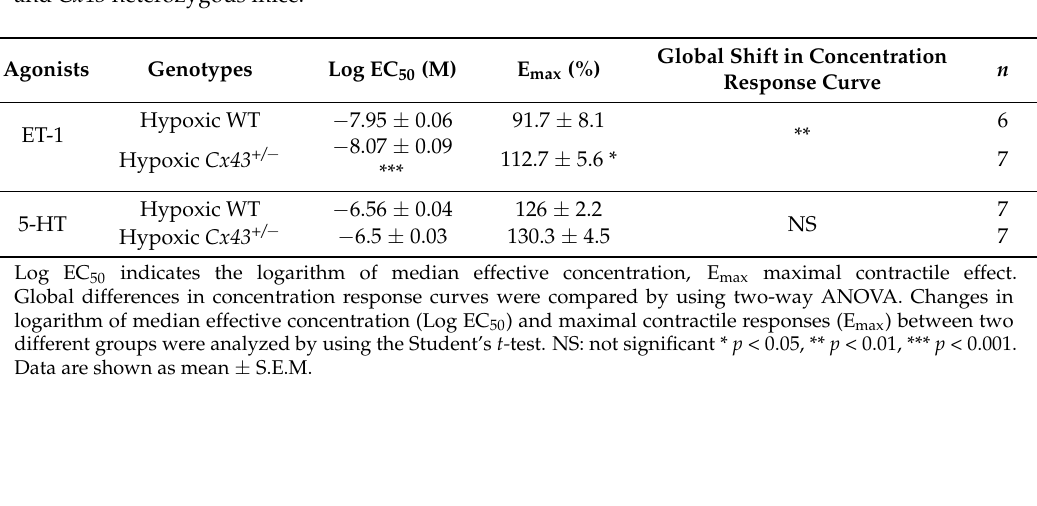
Figure 6. Assessment of the development of right ventricular hypertrophy by right ventricular weight ratio left ventricle plus septal weight (RV/LV+Septum) ( A ). Concentration response curves (CRCs) to ET-1 ( B ) and 5-HT ( C ) in intra-lobar pulmonary arteries derived from hypoxic wildtype (WT) and hypoxic Cx43 heterozygous ( Cx43 +/ − ) mice. Data are shown as mean ± S.E.M. Data in panel A were analyzed by two-way ANOVA. In panels B and C , global differences in CRCs were compared by two-way ANOVA. Changes in the logarithm of median effective concentration (Log EC 50 ) and maximal contractile responses (E max ) between two different groups were analyzed by using the Student’s t -test * p < 0.05, ** p < 0.01, *** p < 0.001, n = 5–7 per group. The statistical symbol shown on the right hand side of graph B indicates a global shift in the CRC. The symbol underneath the curve indicates changes in the median effective concentration (EC 50 ) while the symbol above the curve indicates changes in the maximal response (E max ). Table 3. The contractile effects of ET-1 and 5-HT in intra-lobar pulmonary arteries of hypoxic wildtype and Cx43 heterozygous mice.